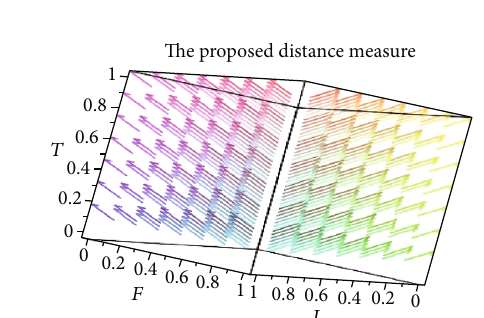
Figure 1: Distance measures of Examples 1, 2, 3, and 4.